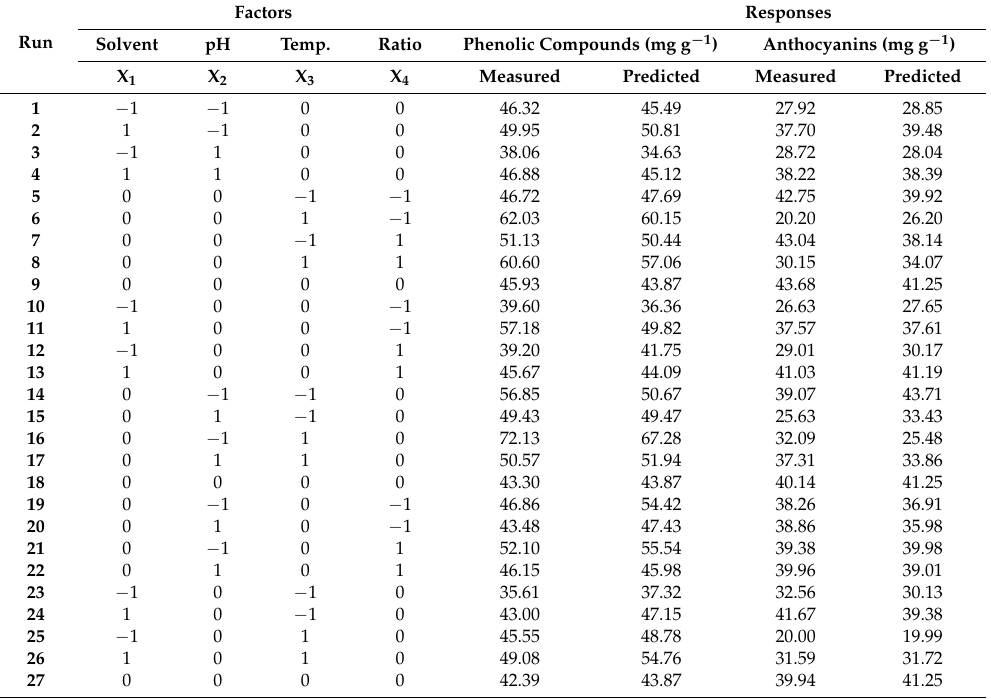
Table 1. Box–Behnken design matrix with coded variables and measured and predicted responses.